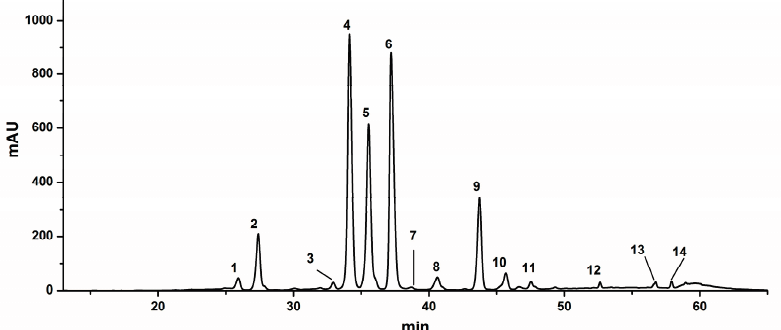
Figure 1. The HPLC profile of flavonoids in fraction II from lotus leaves recorded at 350 nm.